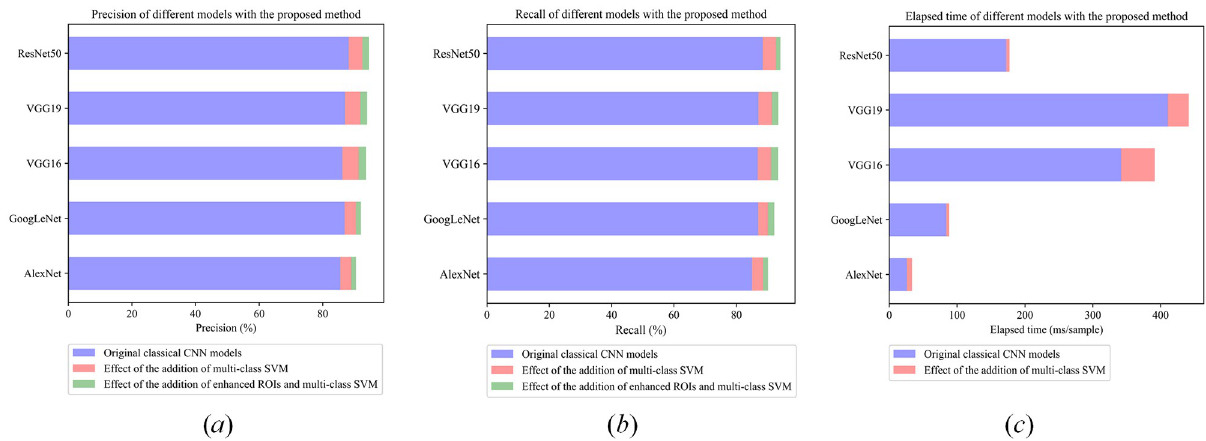
Fig 8. Impacts of multi-class SVM and enhanced ROIs. ( a ) Precision of different models with the proposed method; ( b ) Recall of different models with the proposed method; ( c ) Elapsed time of different models, the increasement of elapsed time (in light coral) is the average of corresponding models based on original ROIs and enhanced